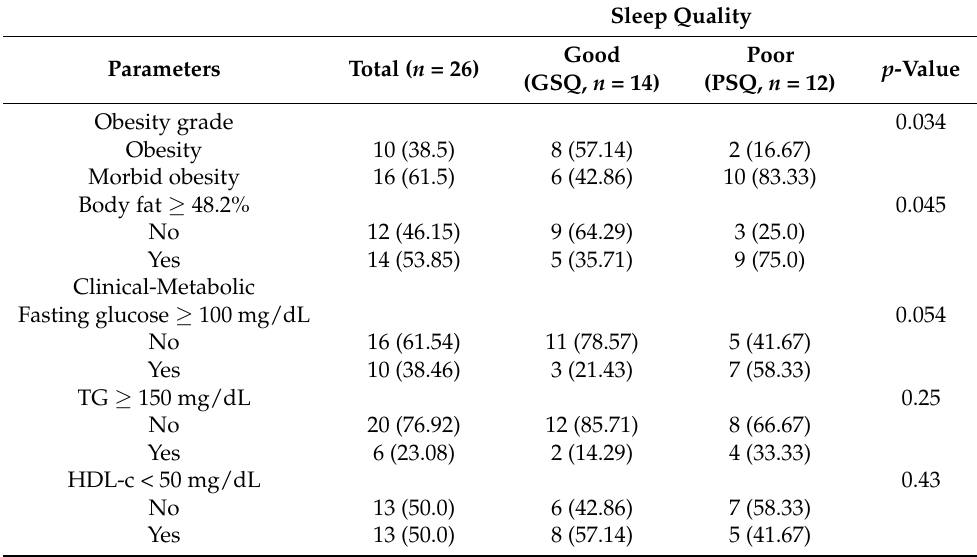
Figure 1. Relationship between poor sleep quality score and ( A ) body mass index (BMI), ( B ) triglyc- erides (TGs) and ( C ) six-minute walking test (6MWt). Table 2. Relationship between sleep quality score and anthropometric, metabolic and fitness pa- rameters. Table 3. Frequency of parameters related to MetS markers according to sleep